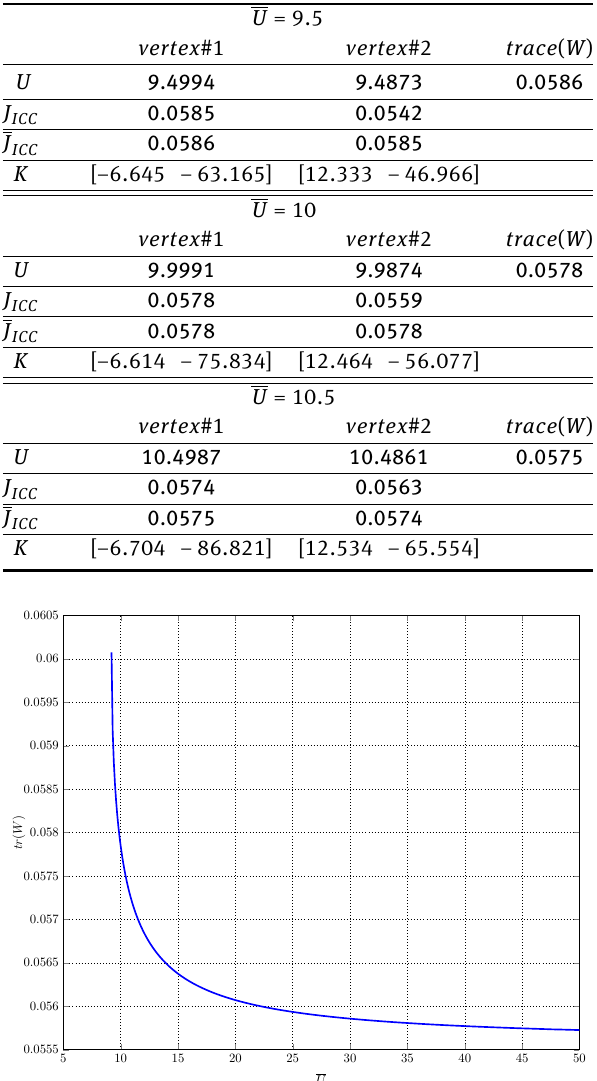
Table 2: ICC cost and Control covariance at the system vertices for Example 1 ( ϵ = 10 −4 ).